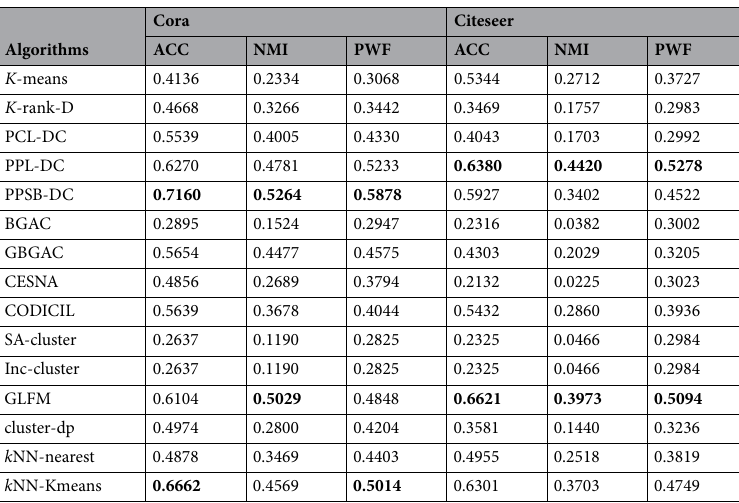
Table 8. Performance of compared algorithms on Cora and